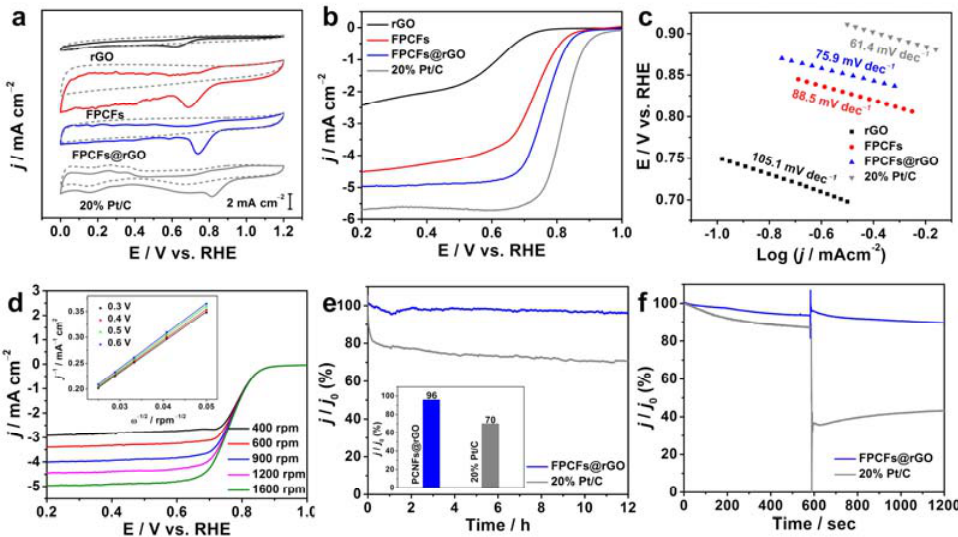
Figure 6. ( a ) CV curves, ( b ) LSV curves, and ( c ) Tafel plots of rGO, FPCFs, FPCFs@rGO, and 20 wt.% Pt/C. ( d ) LSV curves of FPCFs@rGO at a series of rotation rates from 400 to 2000 rpm with a scan rate of 10 mV s − 1 . ( e ) Long-term durability (inset: comparison of current density after chronoamperometry) and ( f ) methanol immunity tests of FPCFs@rGO and 20 wt.% Pt/C.